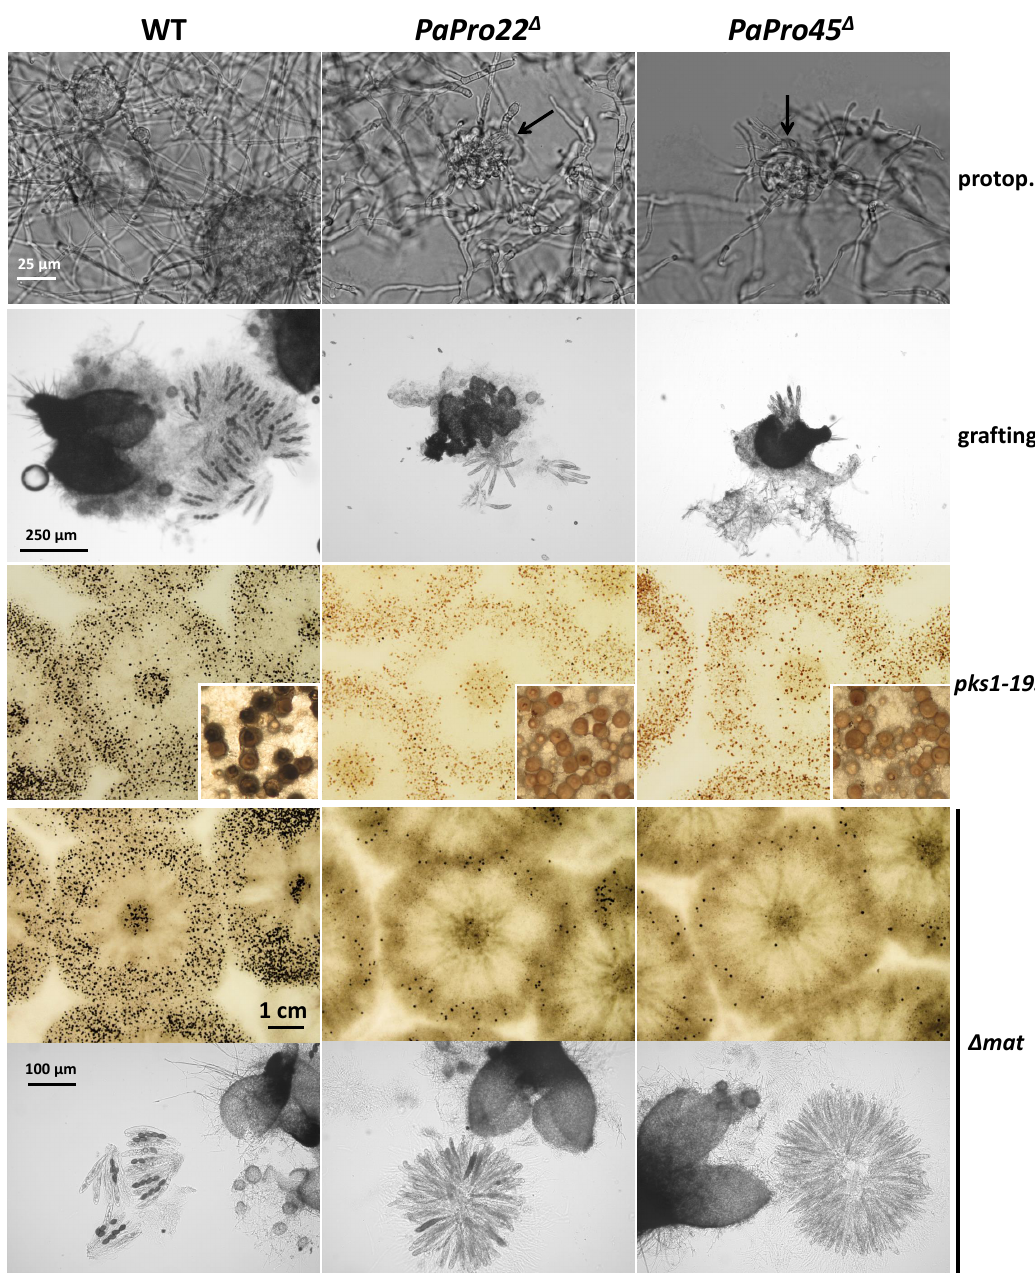
Figure 11. Fertility defect of the PaPro22 ∆ and Papro45 ∆ mutants. From top to bottom: Both PaPro22 ∆ and Papro45 ∆ differentiate small and abnormal-looking protoperithecia (arrows). Wild type perithecia grafted onto PaPro22 ∆ and Papro45 ∆ mycelia stopped their development, while those grafted onto wild type (WT) continued their development by enlarging and producing abundant progeny. Heterokaryons between psk1-193 and the PaPro22 ∆ and Papro45 ∆ mutants produced only non-pigmented fruiting bodies, while those made with the wild-type produced both pigmented and non-pigmented fruiting bodies. Trikaryons between PaPro22 ∆ and Papro45 ∆ produced few perithecia, unlike the wild type. These did not contain mature asci; observation of the rosette of asci in the mutants showed that their maturation was blocked before ascospore